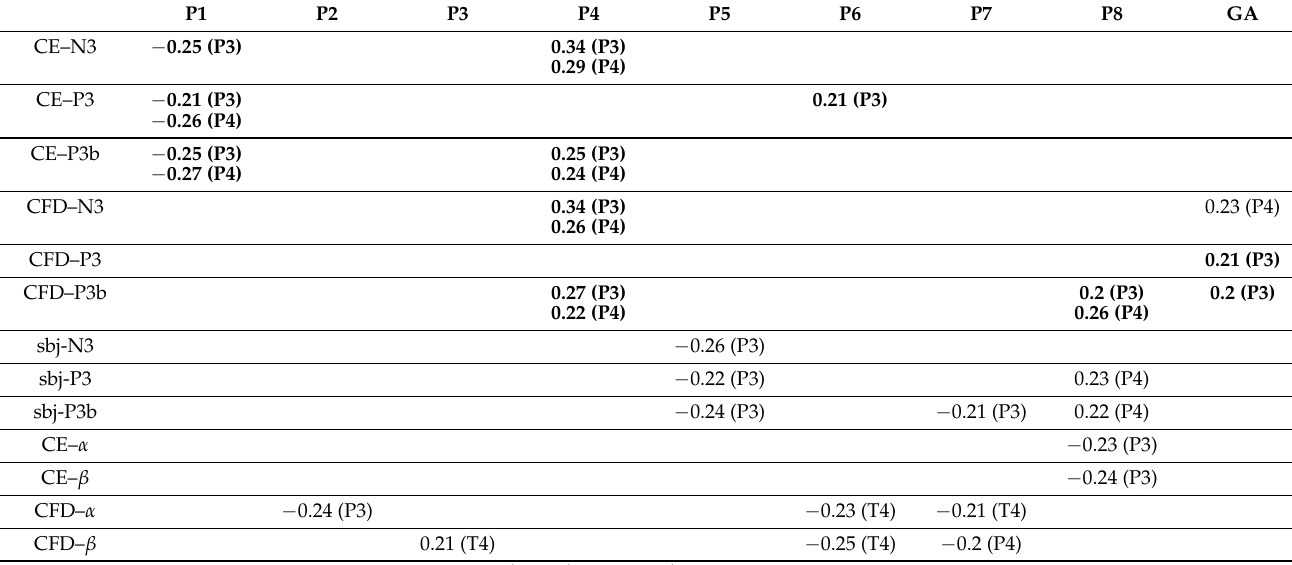
Table 5. Neural signals versus CE and CFD correlations for Nat and Frac images. The result values on Frac textures are shown in bold and normal font for Nat . The respective channel is indicated in